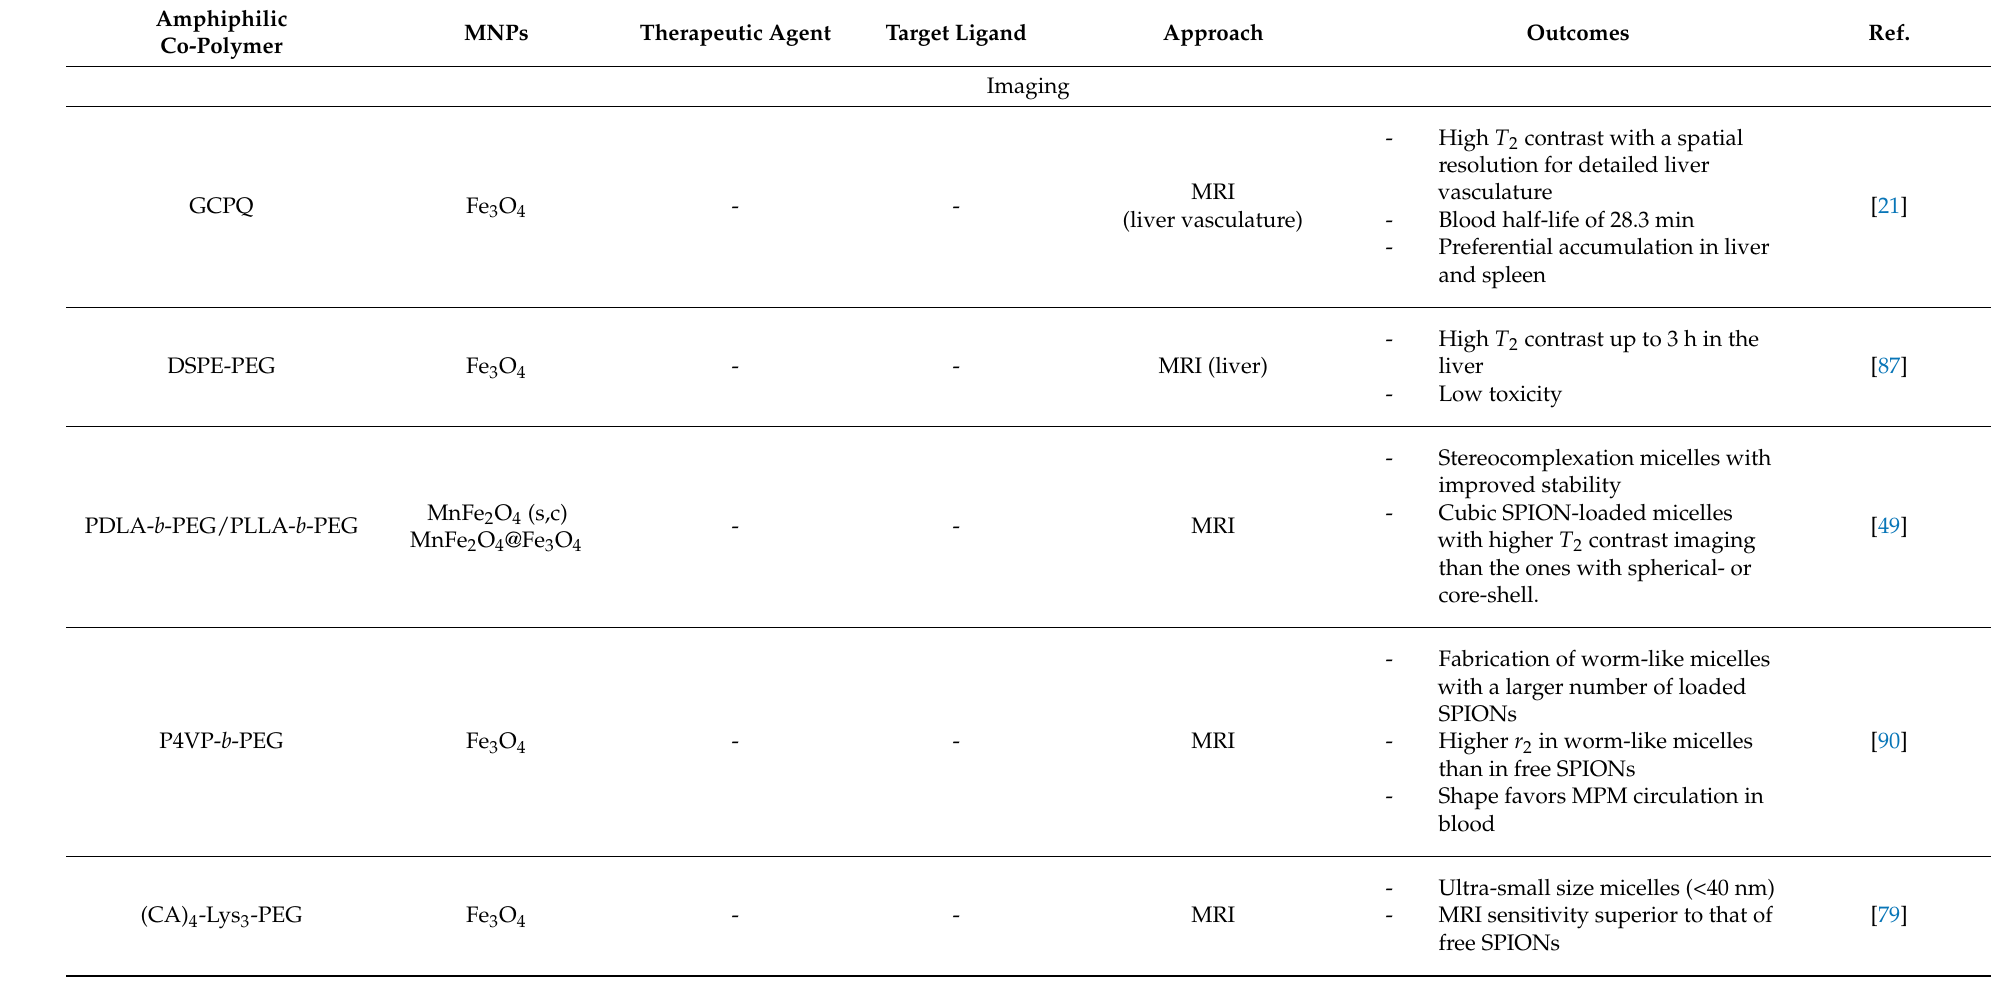
Table 3. Magnetic micelles produced for different